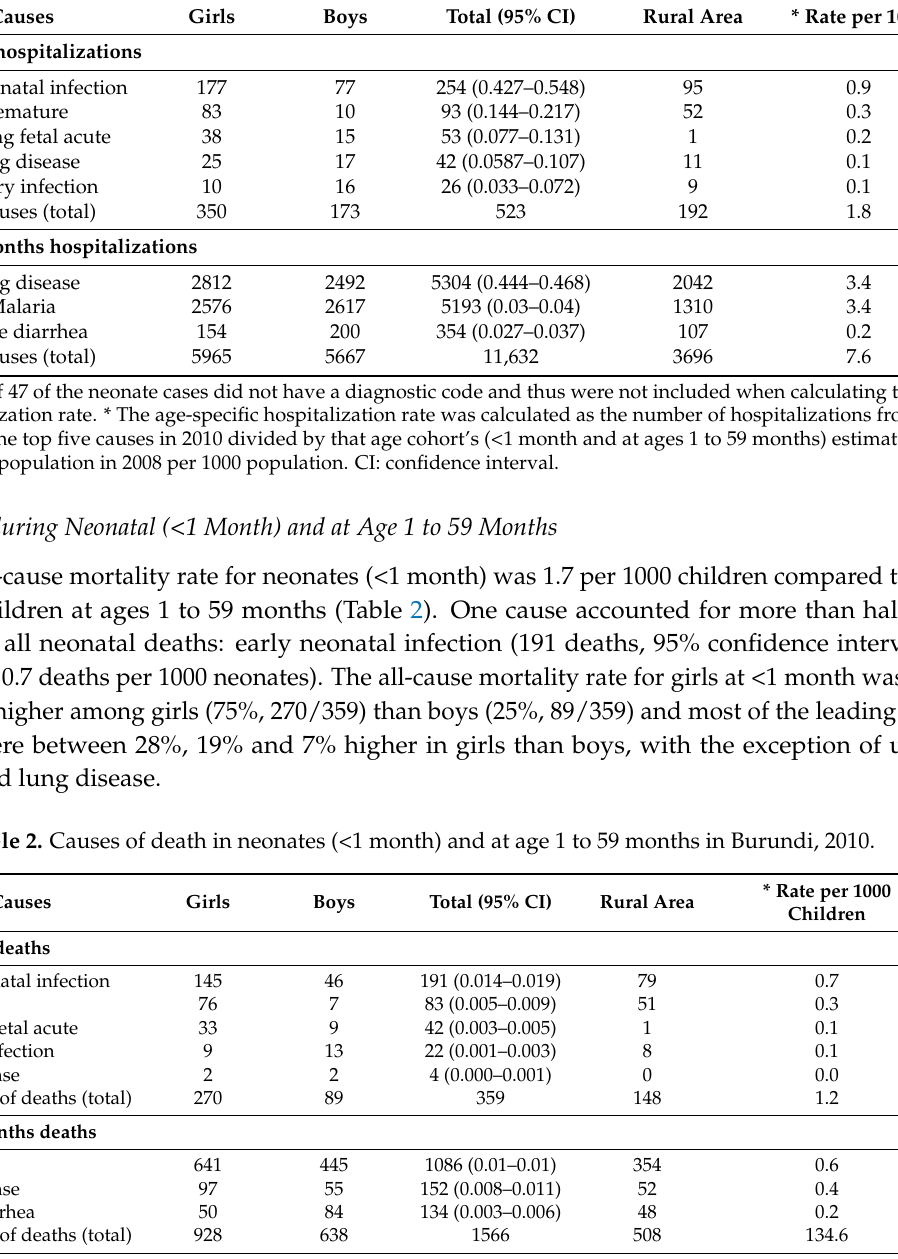
Table 1. Causes of hospitalization in neonates (<1 month) and at age 1 to 59 months in Burundi, 2010. Causes